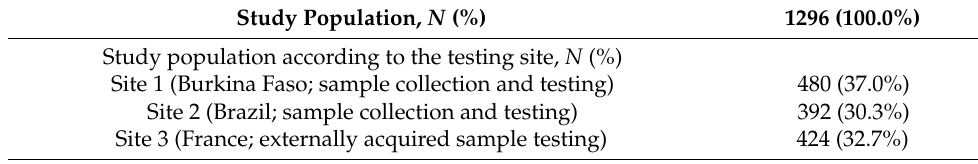
Table 4. Patients’